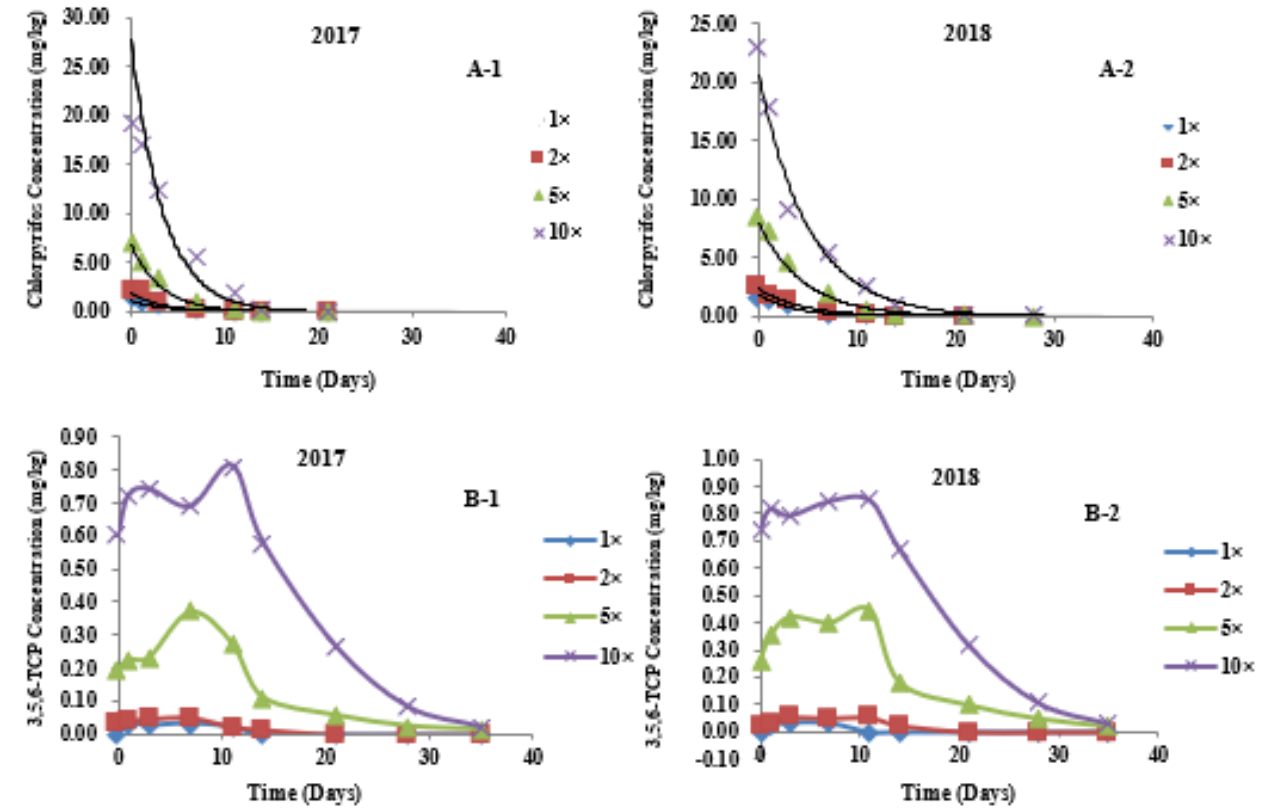
Figure 4. Degradation curves of chlorpyrifos and its metabolite 3,5,6-TCP at different applied dosages in stems. ( A-1 ) Degradation curves of Chlorpyrifos at different applied dosages in stems in 2017; ( A-2 ) Degradation curves of Chlorpyrifos at different applied dosages in stems in 2018; ( B-1 ) Degradation curves of 3,5,6-TCP at different applied dosages in stems in 2017; ( B-2 ) Degradation curves of 3,5,6-TCP at different applied dosages in stems in 2018. 1 × : recommended dosage. 2 × : twofold recommended dosage. 5 × : fivefold recommended dosage. 10×: tenfold recommended dosage.